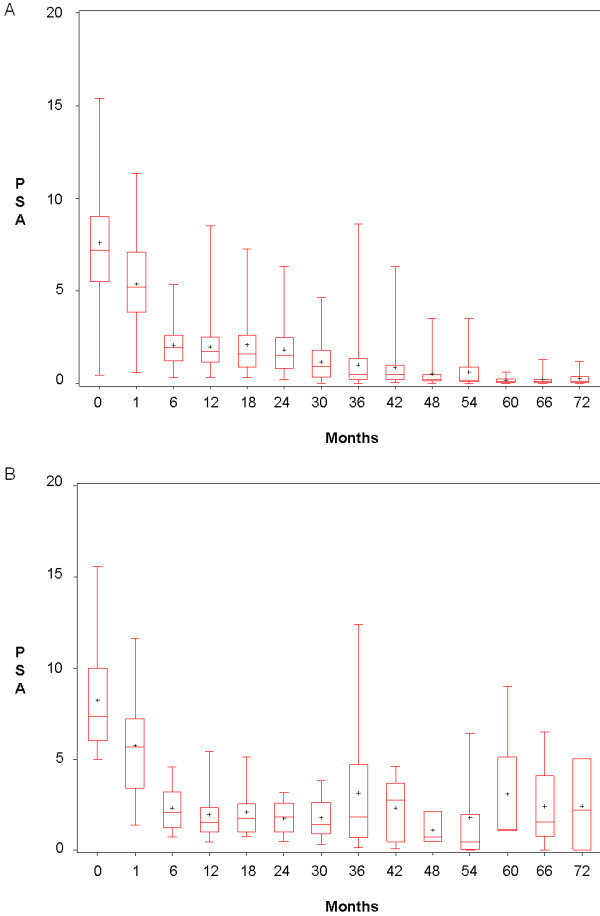
A and B. Distribution of PSA values per visit for patients who had bounce or relapsed. Figure 1A for bounce and B represents relapse.